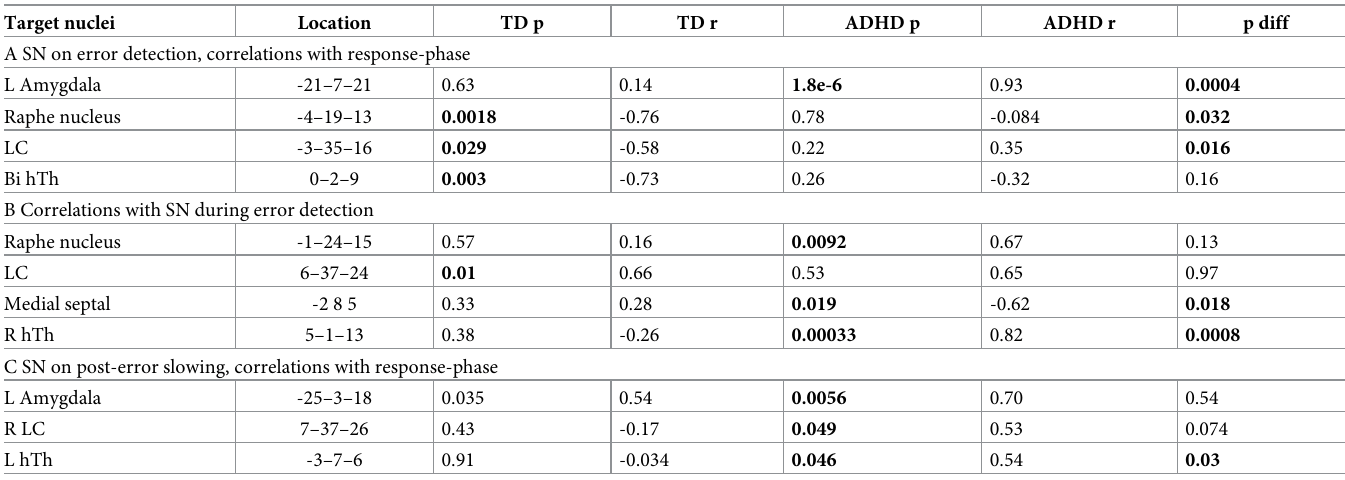
Table 3. Correlations with substantia nigra (SN).